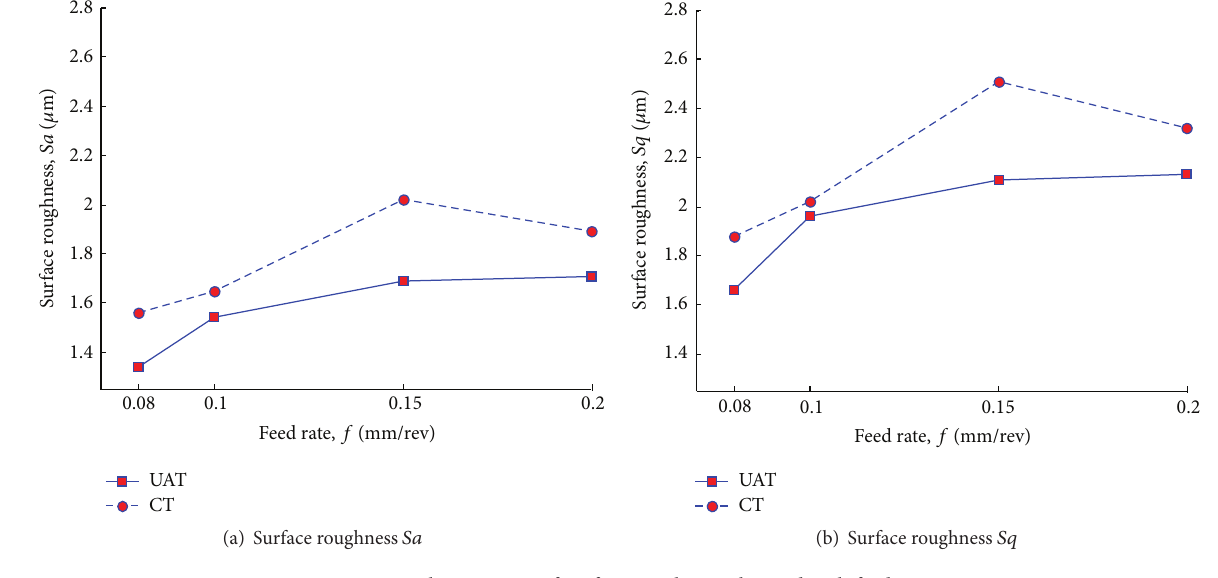
Figure 18: Relation curve of surface roughness changed with feed rate.